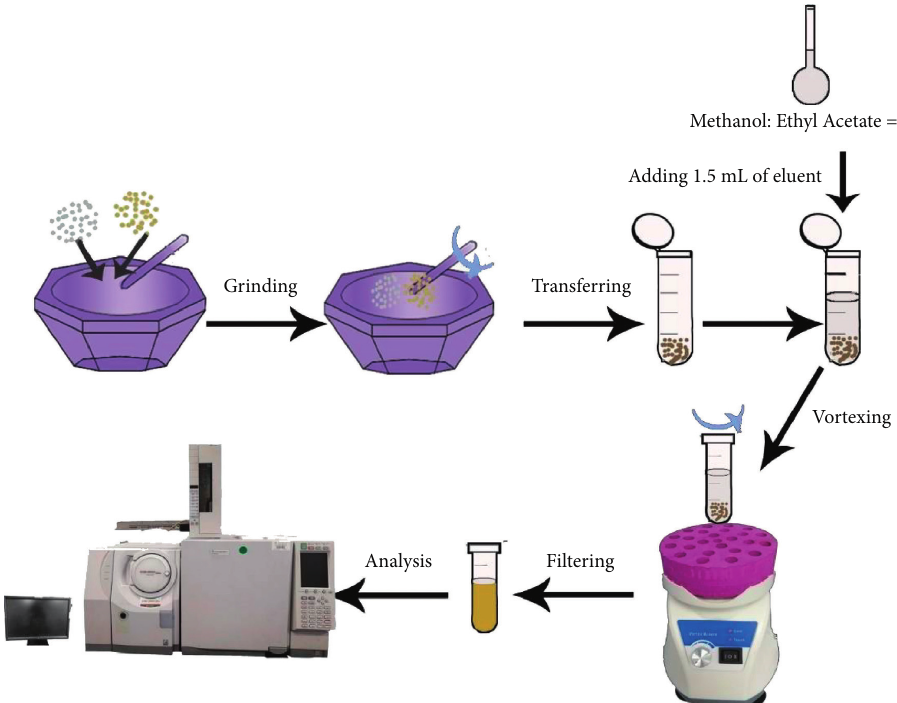
Figure 2: Schematic diagram of binary eluent based vortex-assisted